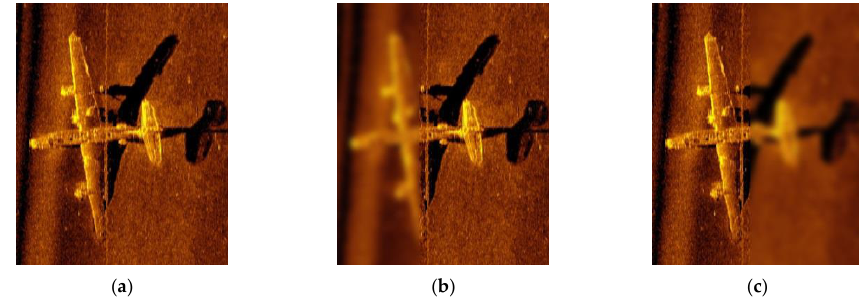
Figure 4. Aircraft wreckage. ( a ) Original image. ( b ) Left region blurred. ( c ) Right region blurred.